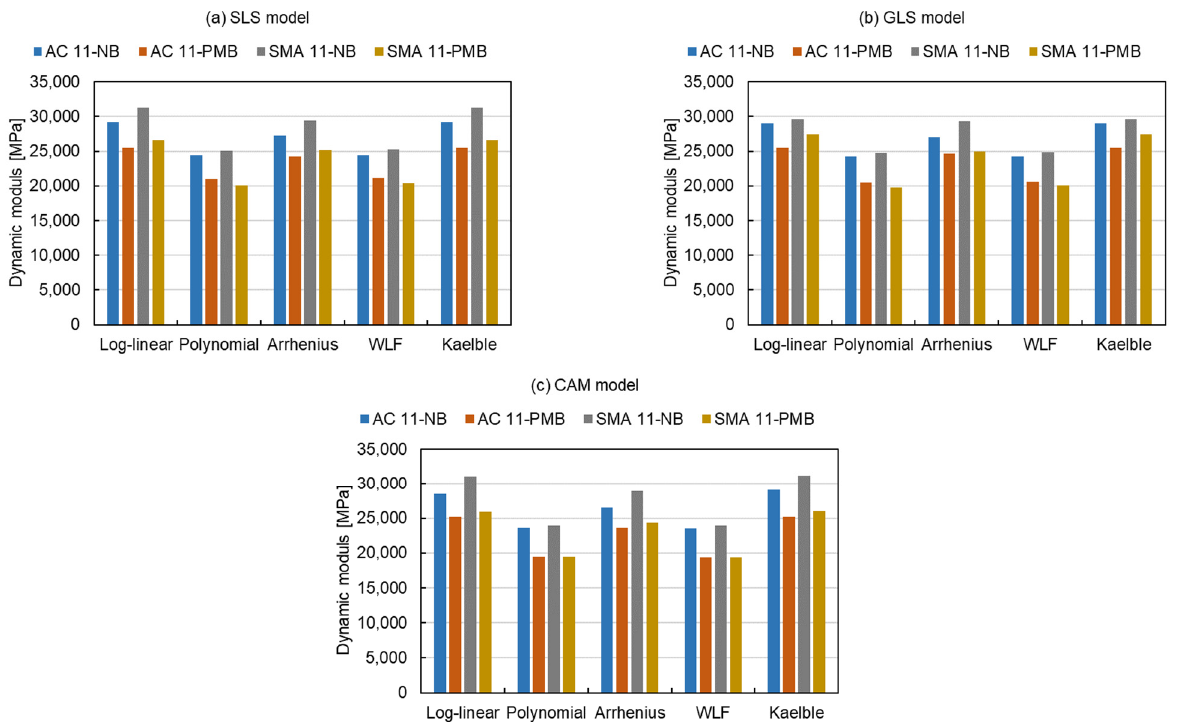
Figure 7. Modelling values of dynamic modulus at the reduced frequency of 10 4 Hz ( T r = 15 °C). The modelling values of the dynamic modulus at the reduced frequency of 10 − 2 Hz ( T r = 15 °C) are given in Figure 8 and have a similar trend as the results at 10 4 Hz, which can also be divided into the same two categories. The former one has an average 19% higher dynamic modulus than the latter one. The results of Figures 7 and 8 indicate that the modelling values of dynamic modulus fitted by the log-linear equation, Arrhenius equation and Kaelble equation are approximately 20% higher than the ones fitted by the polynomial equation and the WLF equation, both at high and low reduced frequencies.